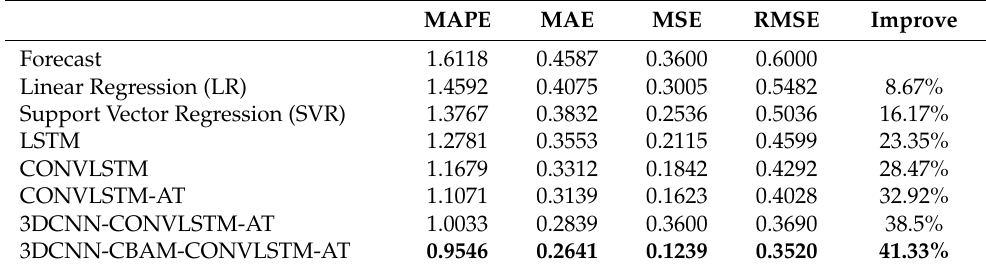
Table 1. The experimental results of SST correction. Bold entries show the best results. MAPE MAE MSE RMSE Improve Forecast 1.6118 0.4587 0.3600 0.6000 Linear Regression (LR) 1.4592 0.4075 0.3005 0.5482 8.67% Support Vector Regression (SVR) 1.3767 0.3832 0.2536 0.5036 16.17% LSTM 1.2781 0.3553 0.2115 0.4599 23.35% CONVLSTM 1.1679 0.3312 0.1842 28.47% CONVLSTM-AT 1.1071 0.3139 0.1623 32.92% 3DCNN-CONVLSTM-AT 1.0033 0.2839 0.3600 0.3690 3DCNN-CBAM-CONVLSTM-AT